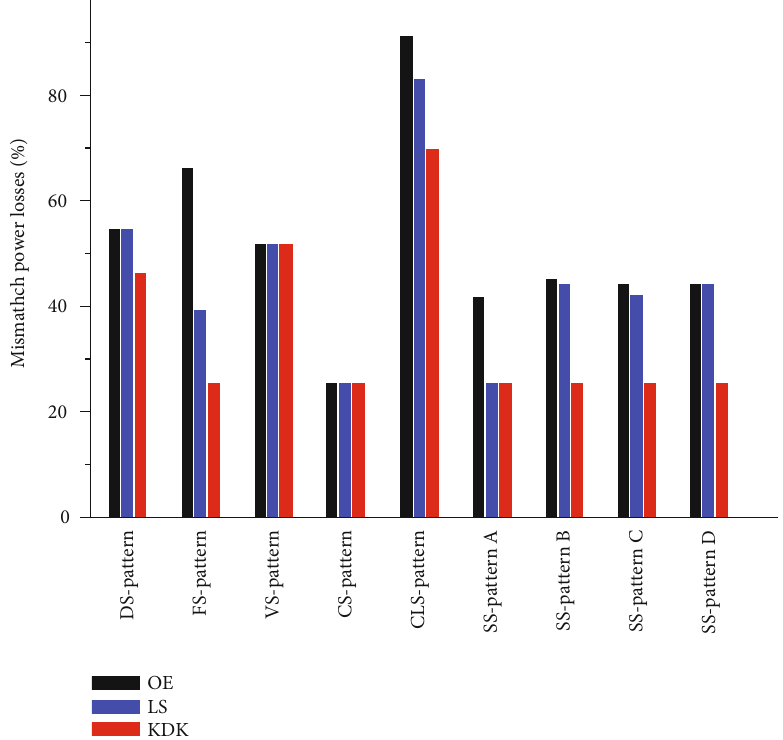
Figure 19: E ff ects of partial shading patterns on mismatch power